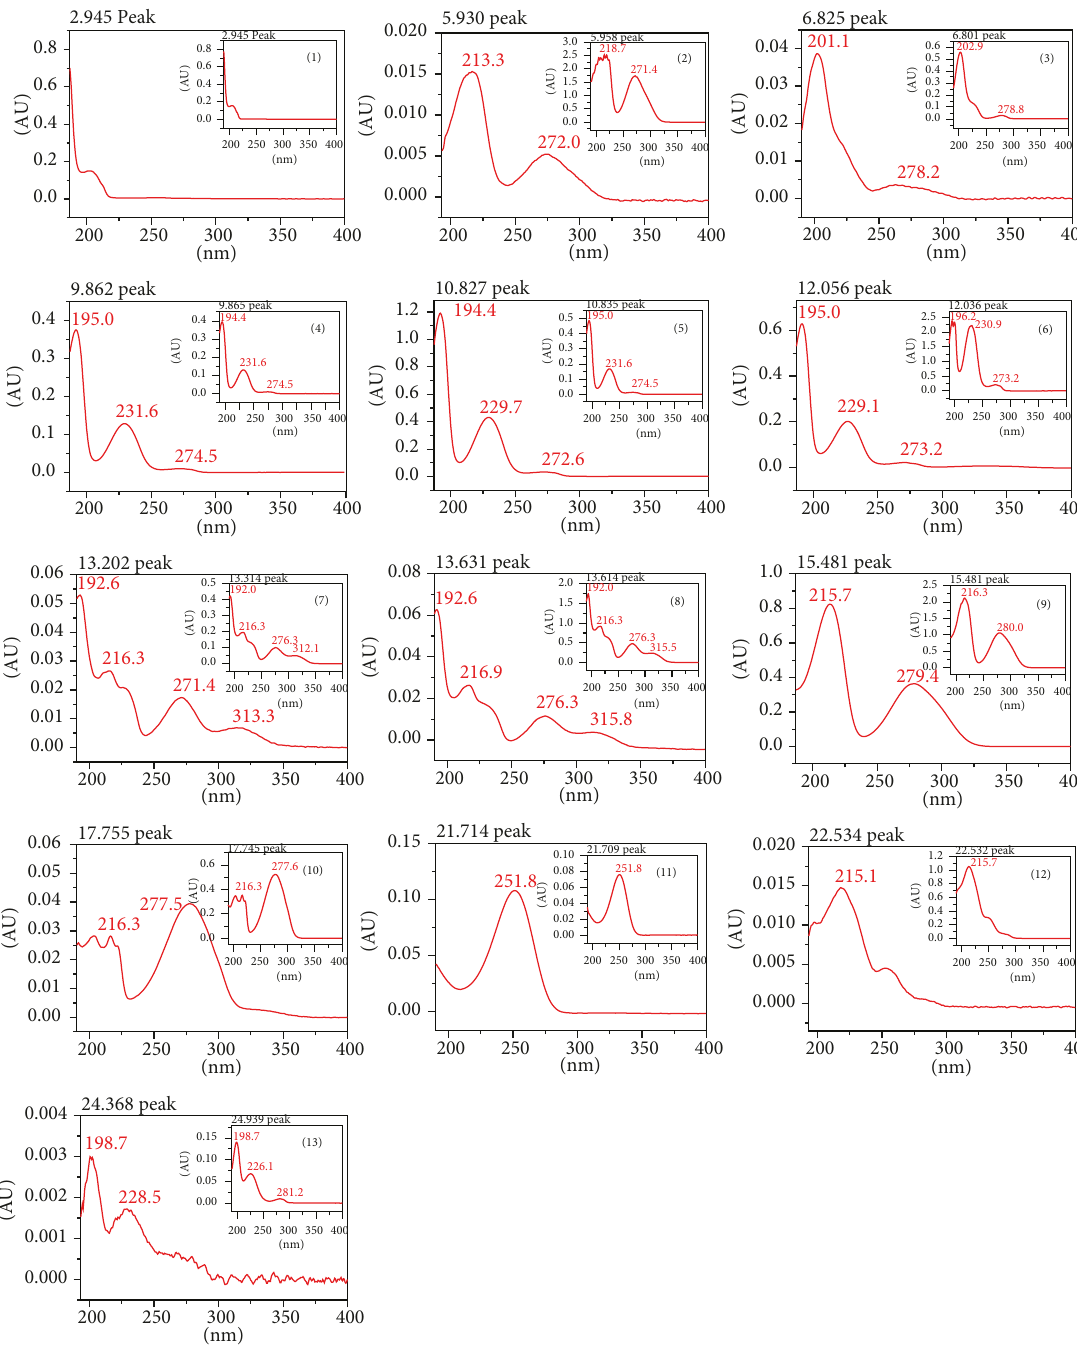
Figure 4: UV spectra of the thirteen marker compounds in SCRT corresponding to the standard solution